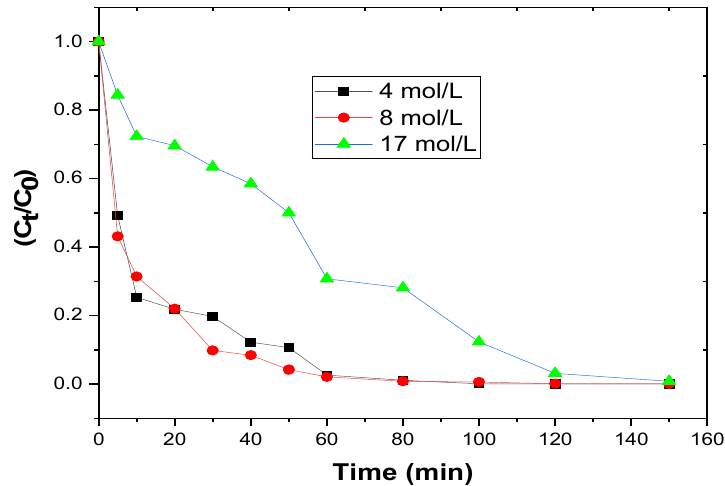
Figure 7. Effect of H 2 O 2 concentration on the degradation of indigo carmine in the aqueous solution .